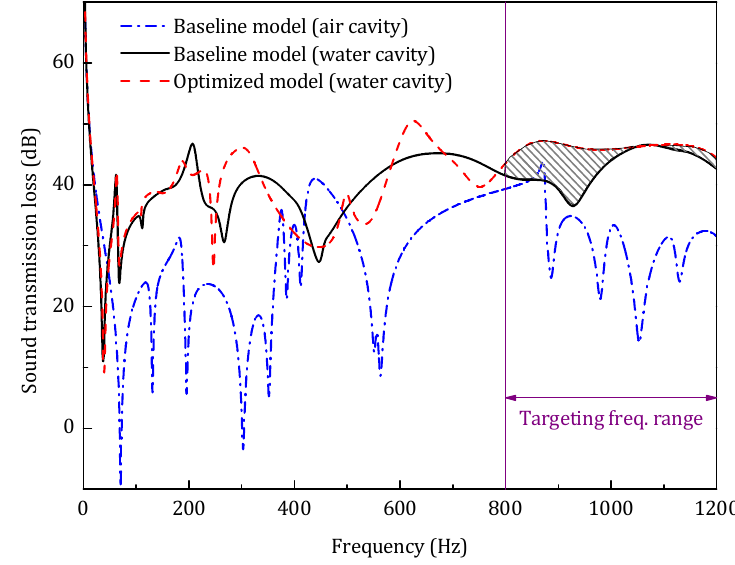
Table 6. Optimization results in high-frequency range with water cavities.